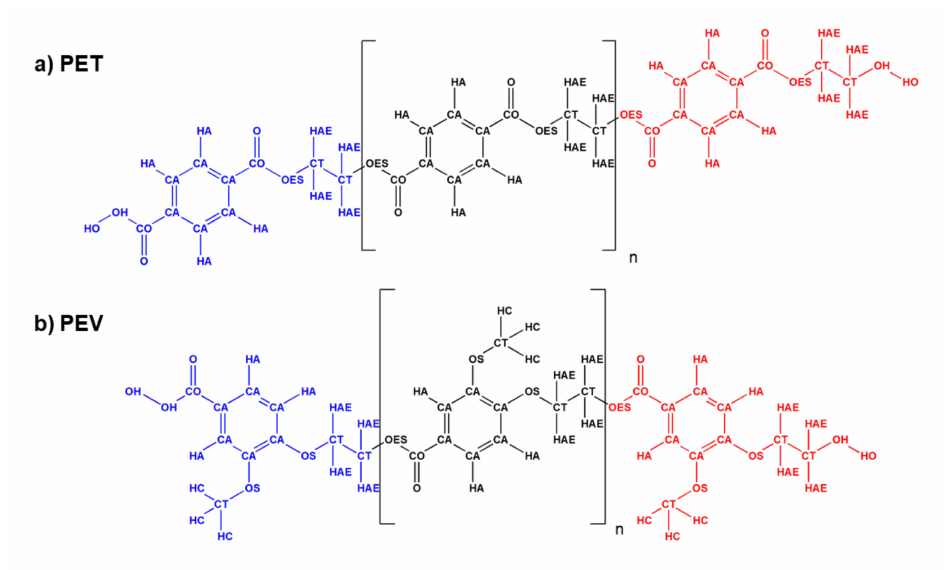
Figure 2. The atom types assigned for the two single-chain polymers: ( a ) PET and ( b ) PEV. The head, middle and tail of structures were represented in blue, black and red,